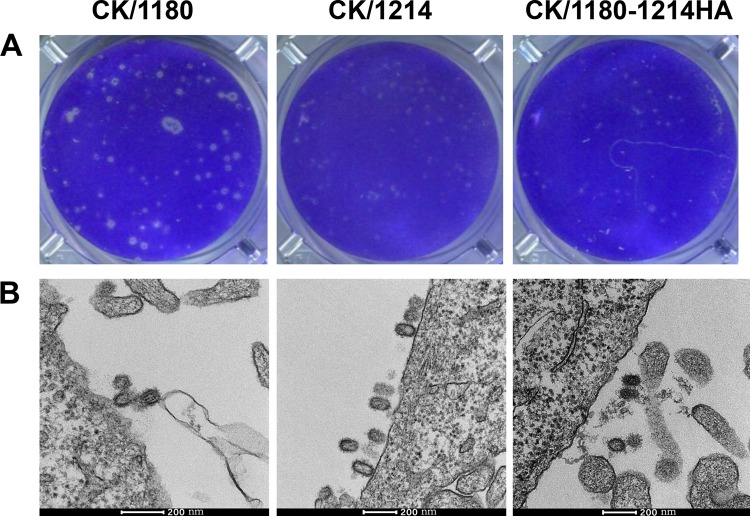
Plaque phenotypes and virus morphology in MDCK cells. (A) Plaque phenotypes of CK/1180, CK/1214, and CK/1180-1214HA viruses. Plaque assays were produced under standard conditions and stained with 0.1% crystal violet. (B) Virus morphology of CK/1180, CK/1214, and CK/1180-1214HA viruses. MDCK cells were infected with viruses at an MOI of 5. At 10 h postinfection, the cells were collected and prepared for virion morphology analysis by using transmission electron microscopy.